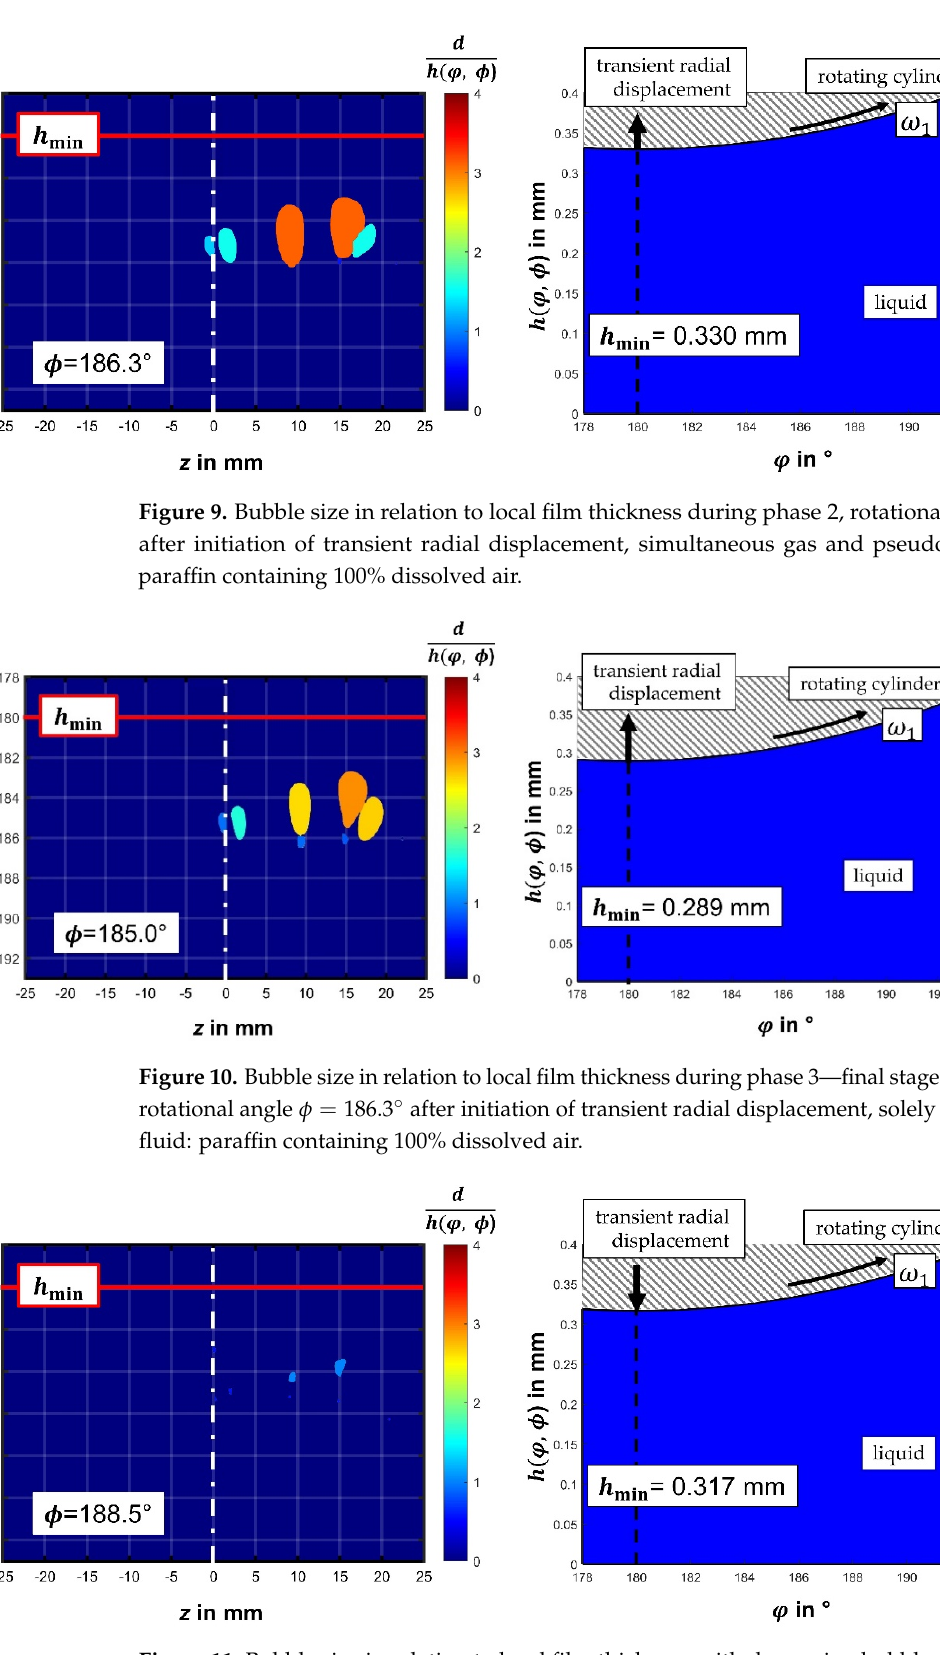
Figure 8. Bubble size in relation to local film thickness during phase 1, rotational angle 𝜙 (cid:3404) 183.5° after initiation of transient radial displacement, inception of bubbles by solely gas cavitation, fluid: paraffin containing 100% dissolved air.